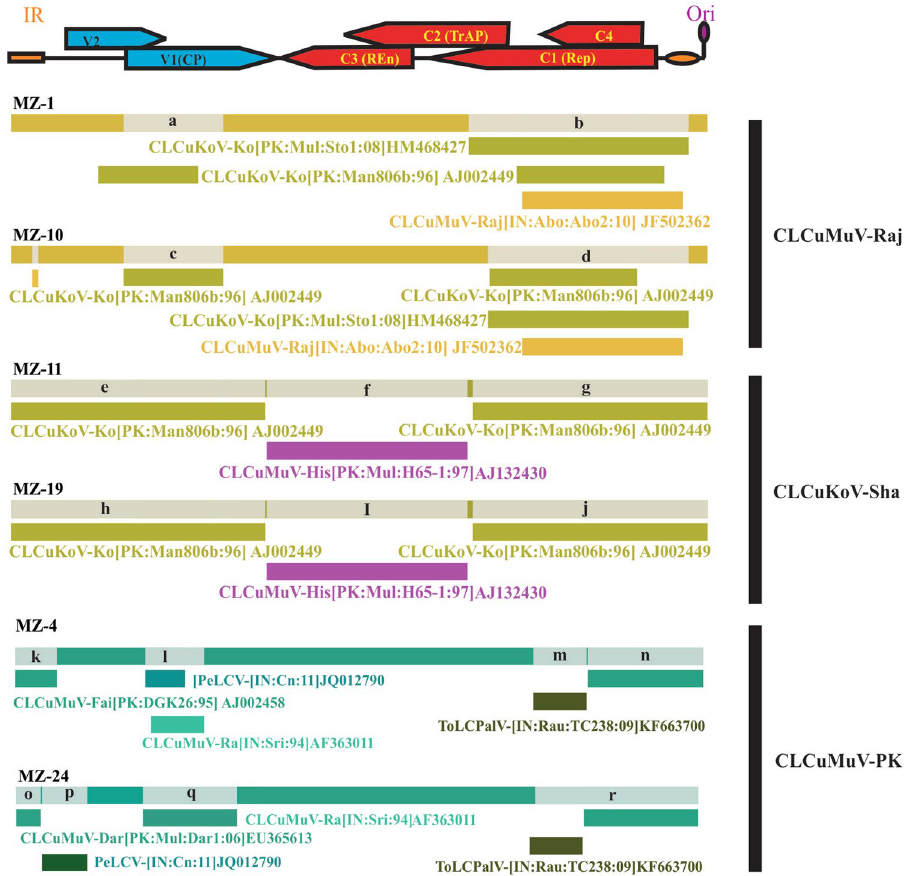
Figure 2. Recombination analyses of begomoviruses with RDP-4. Recombination analysis of Cotton leaf curl Multan virus -Rajasthan (CLCuMuV-Raj), Cotton leaf curl Kokhran virus -Shadadpur (CLCuKoV-Sha) and Cotton leaf curl Multan virus -Pakistan (CLCuMuV-PK). The isolates are grouped into species (marked on the right). A linear genome map of begomoviruses is plotted on top of figure, with position of genes and their orientation indicated by arrows to show recombinant